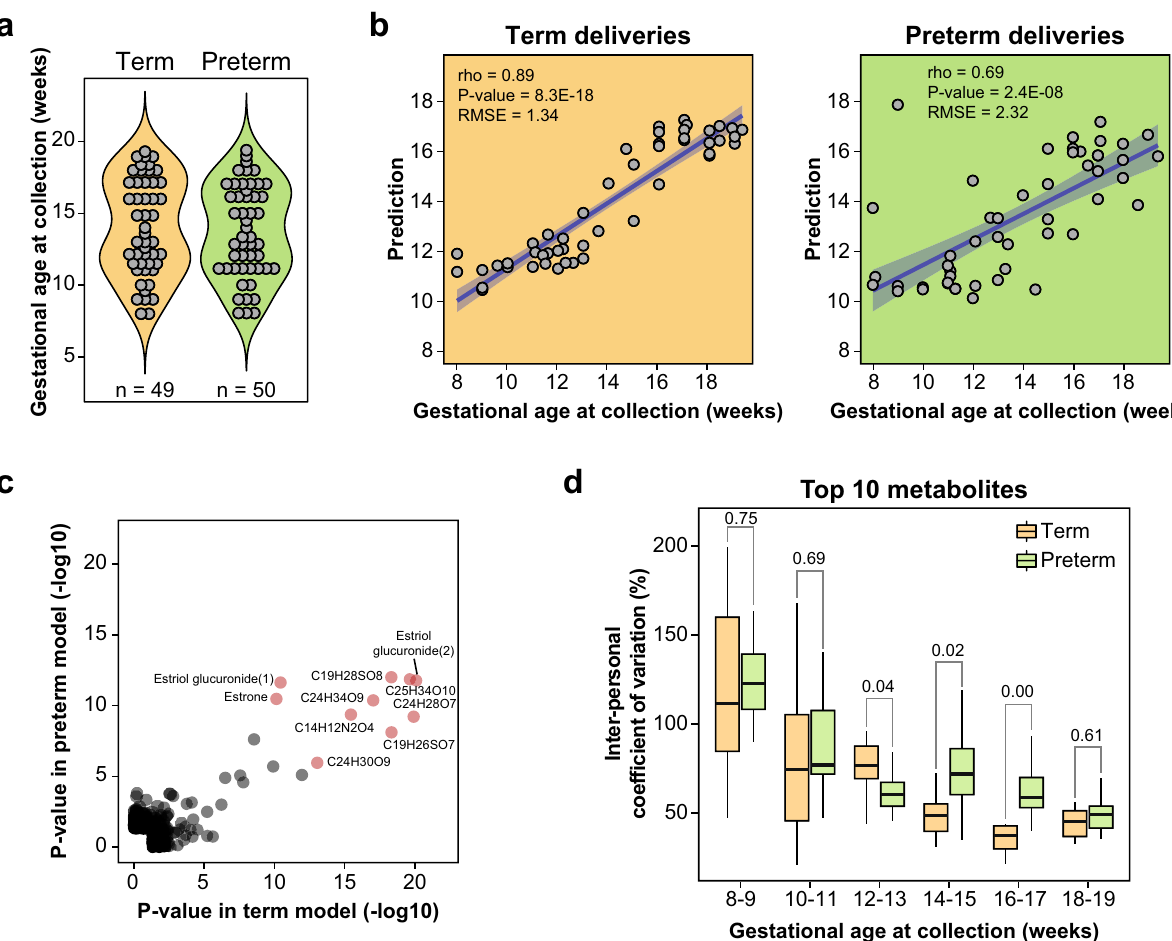
Figure 3. Prediction of gestational age at time of collection in term and preterm pregnancies. ( a ) Distribution of GA at sample collection in term (n = 49) and preterm pregnancies (n = 50). ( b ) Performance of the RF prediction models of GA in term and preterm deliveries. ( c ) P -values of selected metabolites in term and preterm RF models. Metabolites that are most predictive tend to be significant in both models. The top 10 metabolites are represented in red. ( d ) Coefficient of variation of the top 10 metabolites across GA